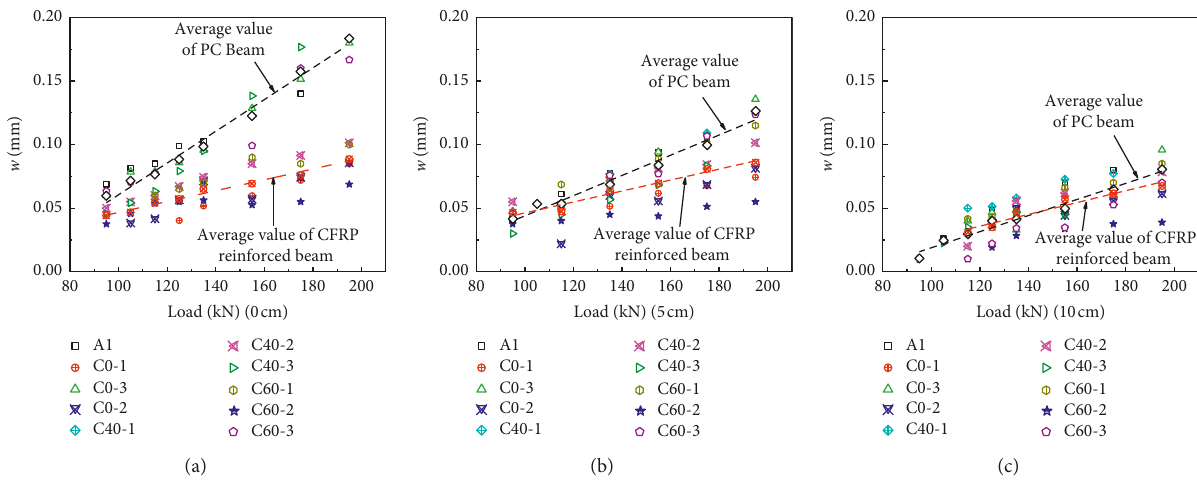
Figure 13: Crack widths and loads curves. (a) Average widths of cracks on the bottom, (b) at 5cm, and (c) at 10cm.